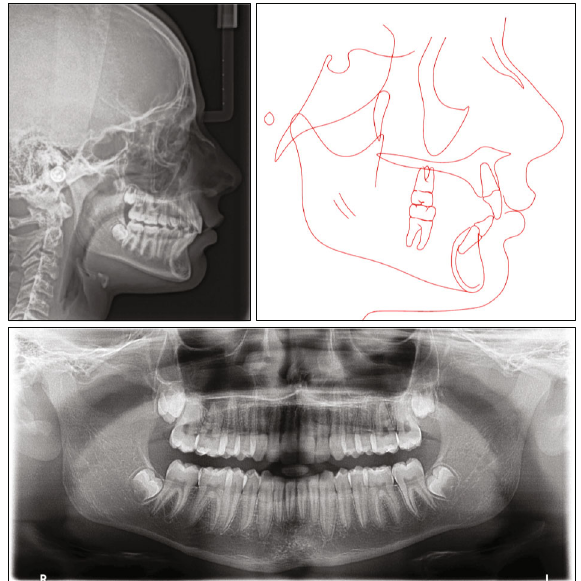
Figure 7: Posttreatment radiographs and